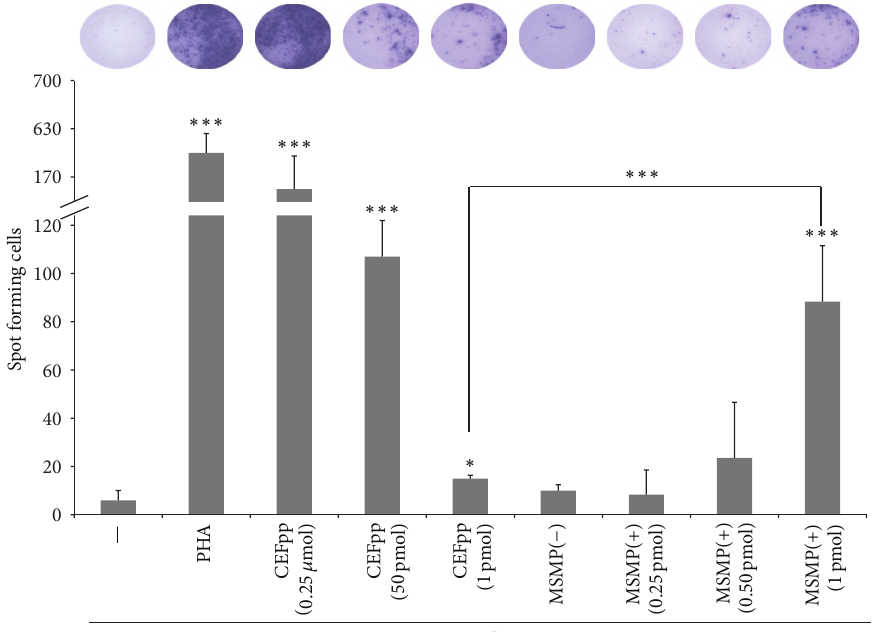
Figure 5: Porous silicon microparticles loaded with antigens trigger the immune response. ELISPOT assays: the incubation of peripheral lymphocytes (PBMCs) from healthy donors with allogenic dendritic cells (MDDC) differentiated and matured in the presence of micro- particles loaded with antigenic peptides (MSMP+) results in the activation of specific CD8 lymphocytes, showed as a synthesis of IFN- 𝛾 . PHA: phytohemagglutinin (1 𝜇 g); CEFpp: CEF peptide pool; MSMP( − ): unloaded microparticles. ∗ 𝑃 < 0.05 ; ∗∗∗ 𝑃 < 0.01